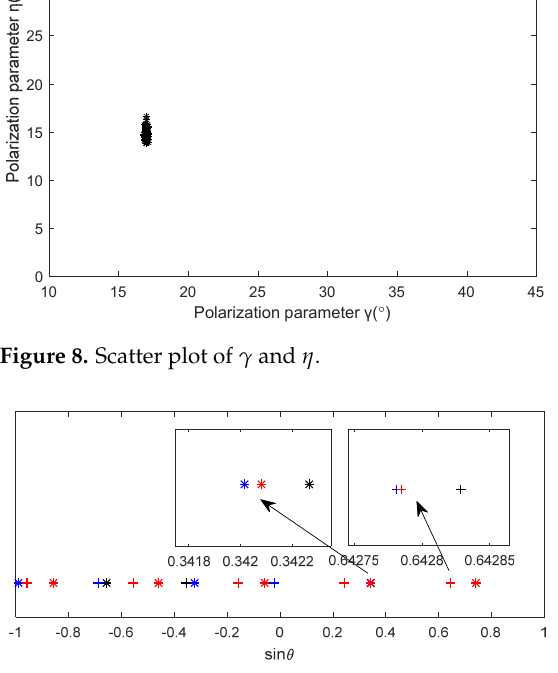
Figure 8. Scatter plot of γ and η .